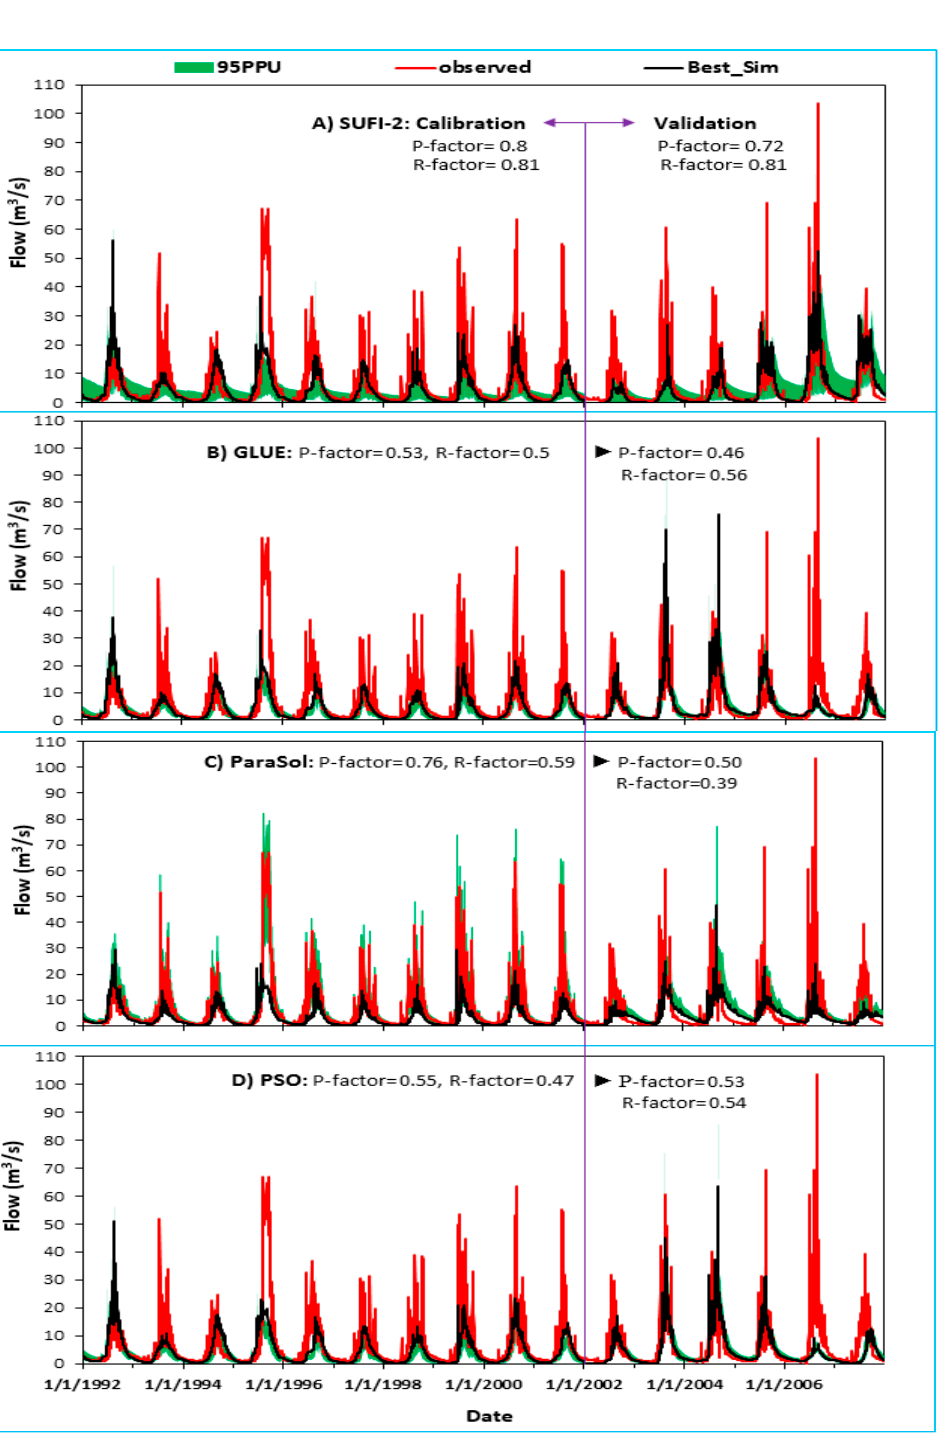
Figure 7. Daily observed flow, 95% model uncertainty, and best estimates for calibration (1992–2001) and validation (2002–2007): SUFI-2 ( A ), GLUE ( B ), ParaSol ( C ), and PSO ( D ).